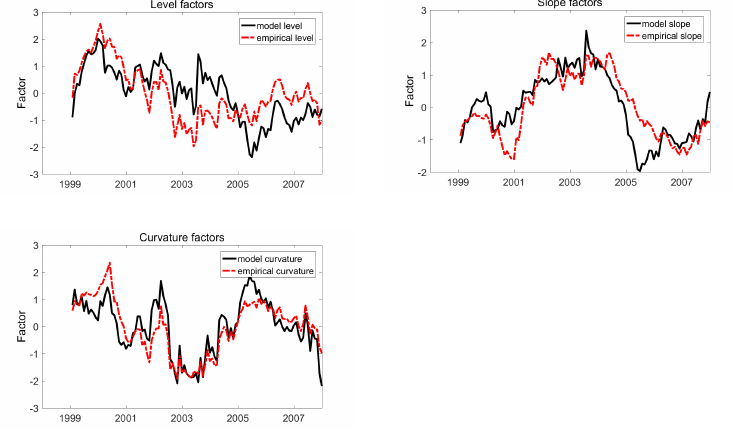
Figure 1. Estimated Factors versus Empirical Factors Explaining Yields to